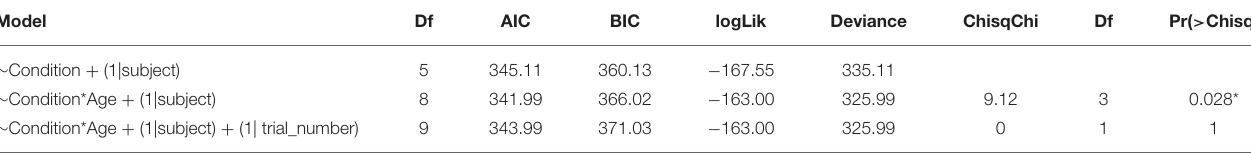
TABLE 6 | Results from the model comparison of the habituation paradigm. Model Df AIC BIC logLik Deviance ChisqChi